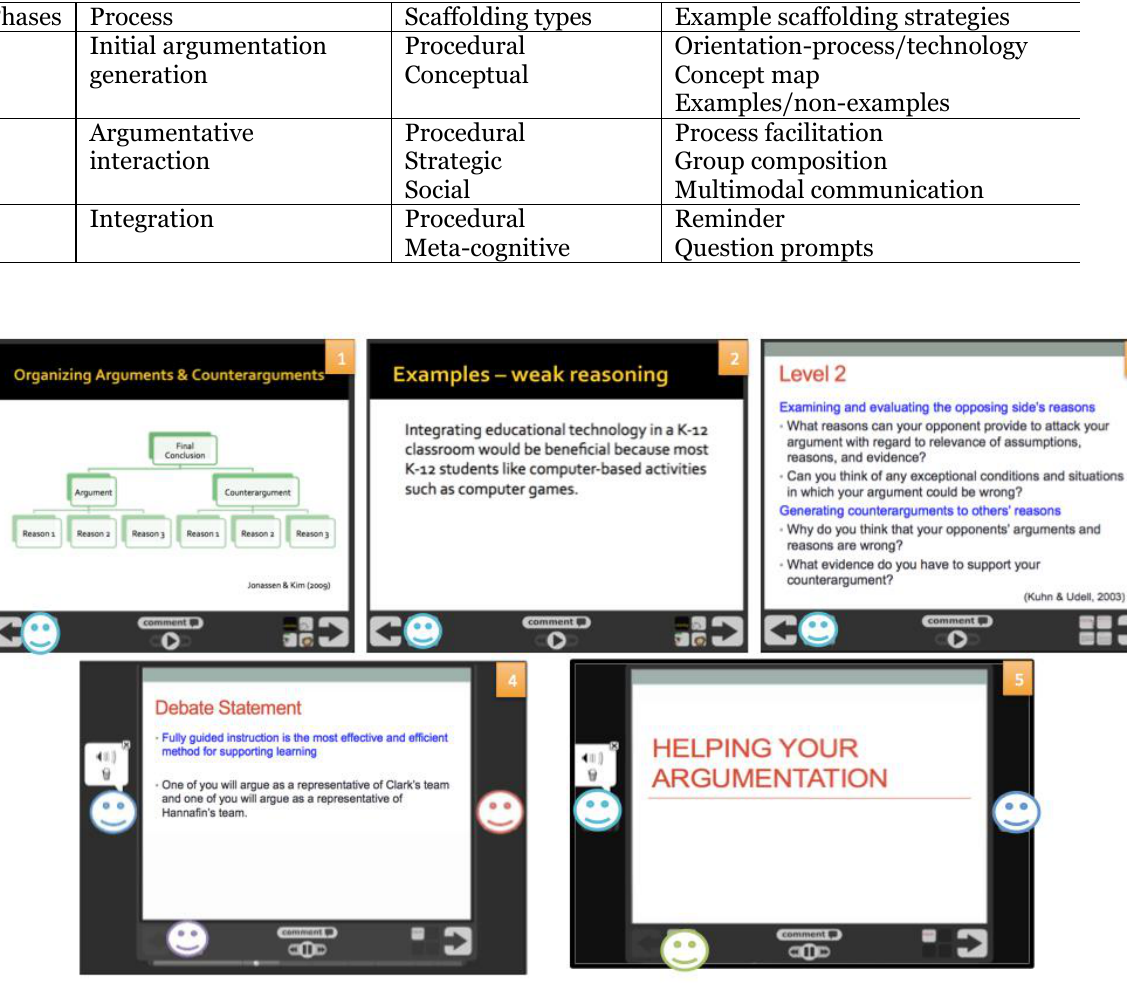
Figure 1 . Screen capture of the VoiceThread interface displaying the video guides and argumentation activity. Frames 1 and 2 indicate conceptual scaffolding, 3 is strategic, and 4 and 5 are